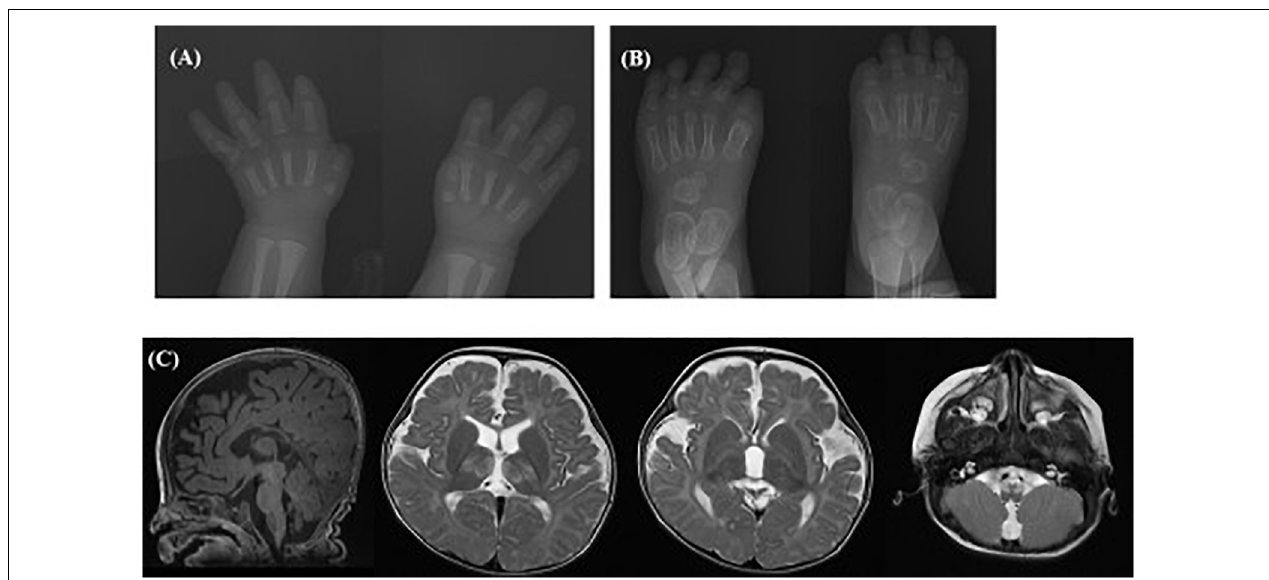
FIGURE 4 | Radiographic images of case #30 with Yunis-Varon dysplasia. X-ray showing hypoplasia and agenesis of the distal phalanx of the (A) fingers and (B) toes. (C) Brain MRI showing diffuse corpus callosal thinning, prominent subarachnoidal space at the frontotemporal convexity, and dilation of the 3rd ventricle, T2 high signal intensity of the bilateral thalami and medulla oblongata of inferior olivary